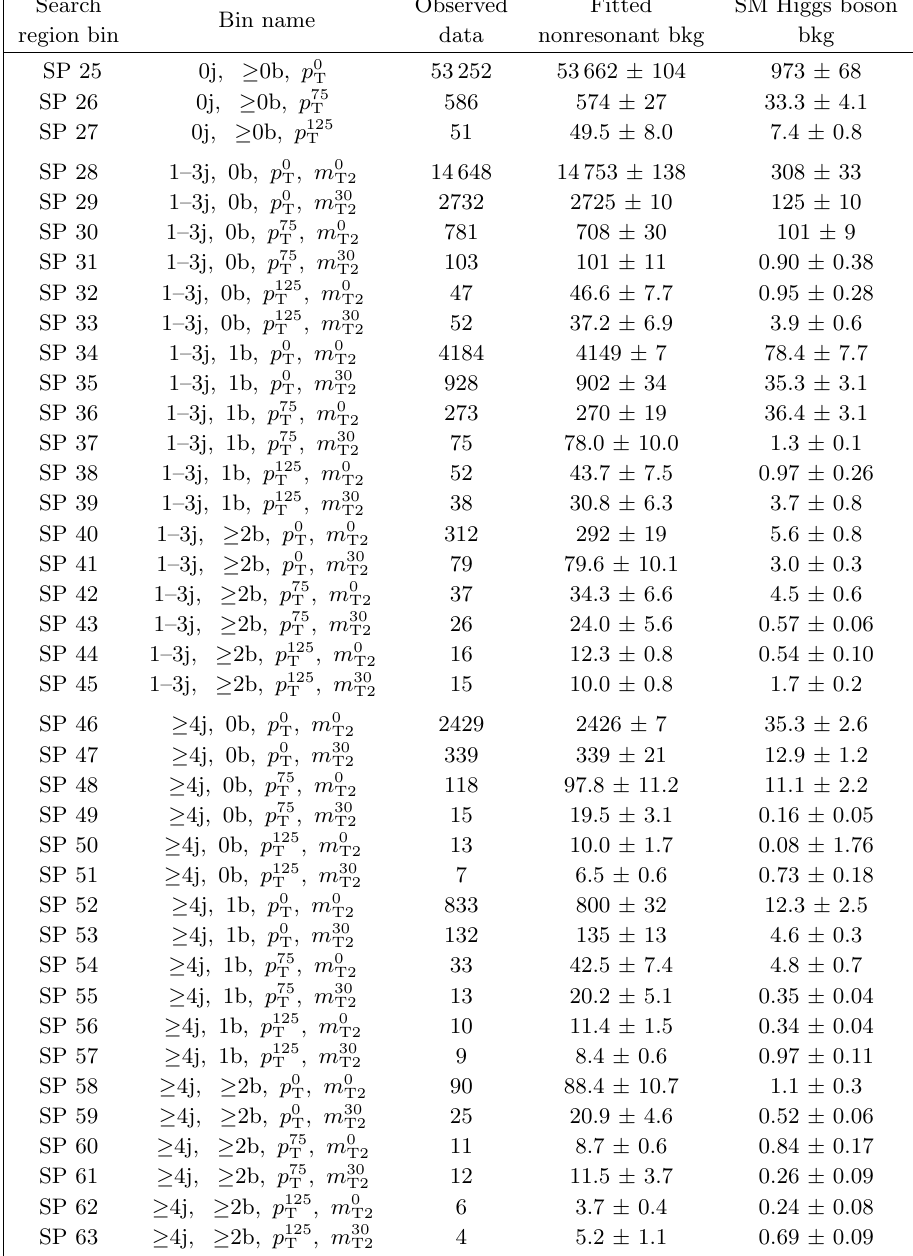
Table 6 . The observed data, (cid:12)tted nonresonant background yields, and SM Higgs boson back- ground yields within the mass window between 122 and 129 GeV are shown for each search region bin in the all-hadronic categories of the SP analysis. The uncertainties quoted are the (cid:12)t uncer- tainties, which include the impact of all systematic uncertainties. The bin names give a short-form description of the search region bin de(cid:12)nition which are given in full in table 3. The labels p 0 p 75 , and p 125 refer to bins de(cid:12)ned by the requirement that p (cid:13)(cid:13) T T and 1.0, and greater than 1.0, respectively. The labels m 0 requirement that m T2 is less than and greater than 30 GeV,